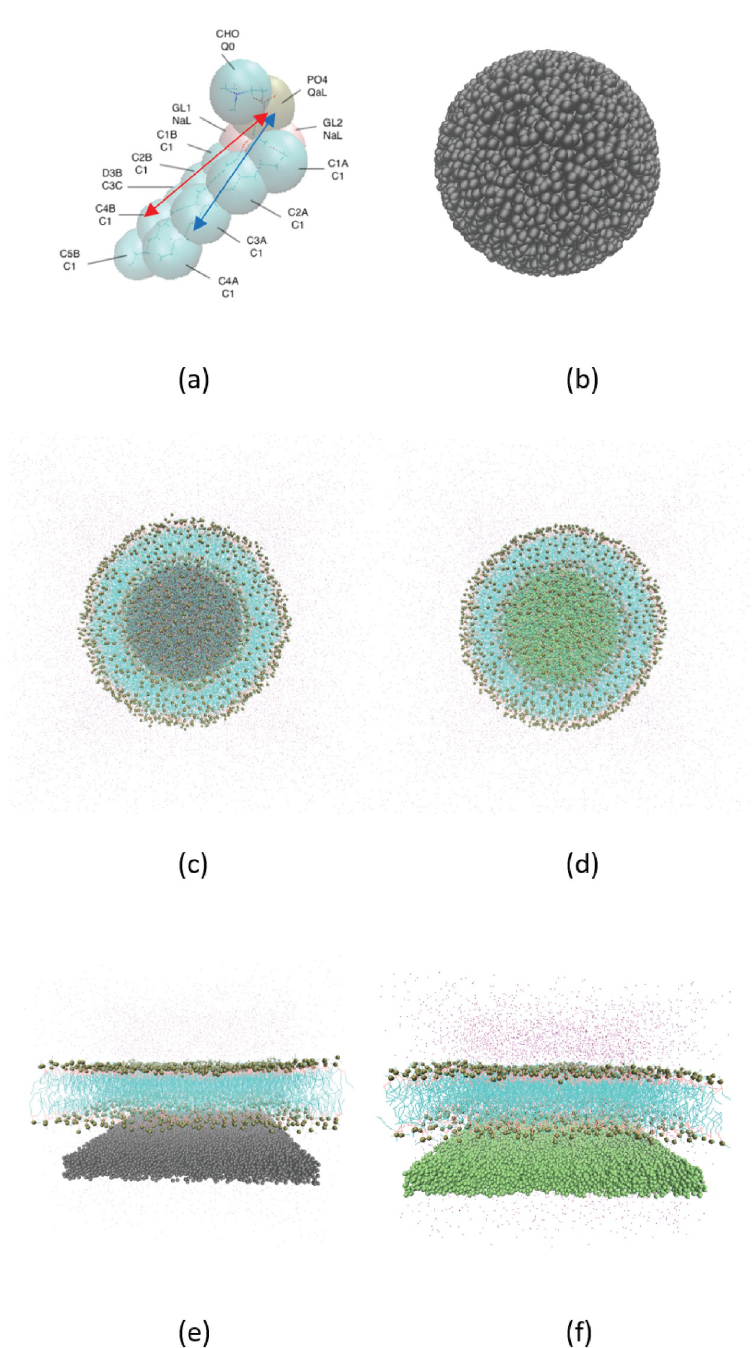
Fig 1. (a) Martini model of the POPC lipid molecule, where the lipid molecule is represented by 13 large spheres (beads). Each of the beads is so labelled that their names are identified on the upper row and their types are identified on the bottom row (for example, the name of the “golden” color bead is “PO 4 ” and its type is “QaL”). The red double arrow shows the definition of l B , the distances between the PO4 beads and the center of C5B, C4B, and C3C beads while the blue double arrow shows the definition of l , the distances between the PO4 beads and the center of C2A, A C3A, and C4A beads. The figure has been reproduced with permission from Jing, H.; Wang, Y.; Desai, P. R.; Ramamurthi, K.; Das, S. Formation and Properties of Self-Assembled Nanoparticle-Supported Lipid Bilayer